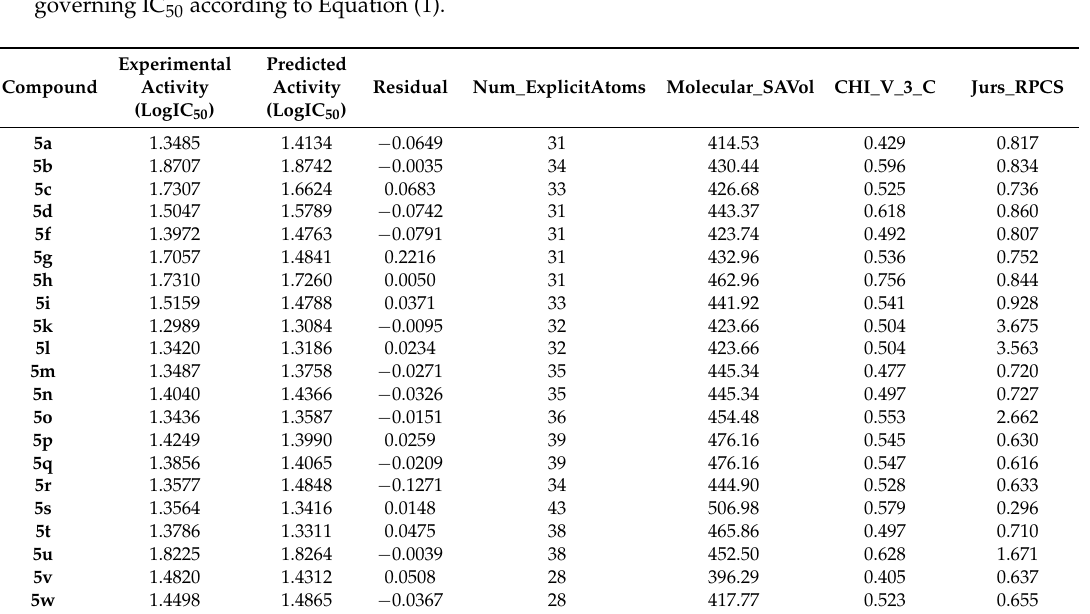
Figure 8. Predicted versus experimental logIC 50 of the tested compounds against MDA-MB-468 cell line according to Equation (1) ( r 2 = 0.842). Table 5. Estimated IC 50 data of the training set against MDA-MB-468 cell line and calculated descriptors governing IC 50 according to Equation (1).